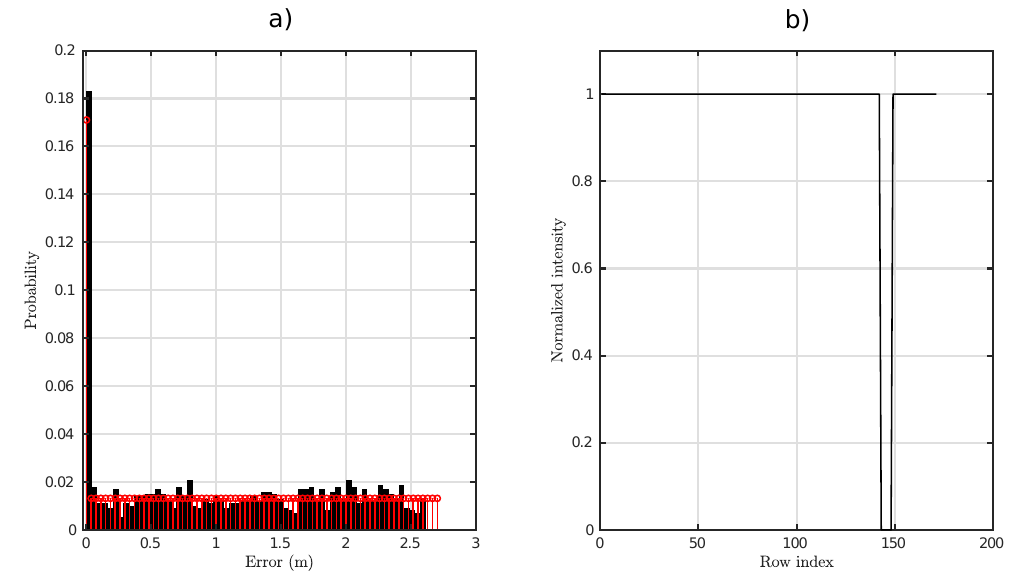
Figure 10. Empirical histogram in black versus theoretical result in red ( a ); and simulated signal within the corresponding ROI at 3 m ( b ). In total, 1024 independent simulations were performed.